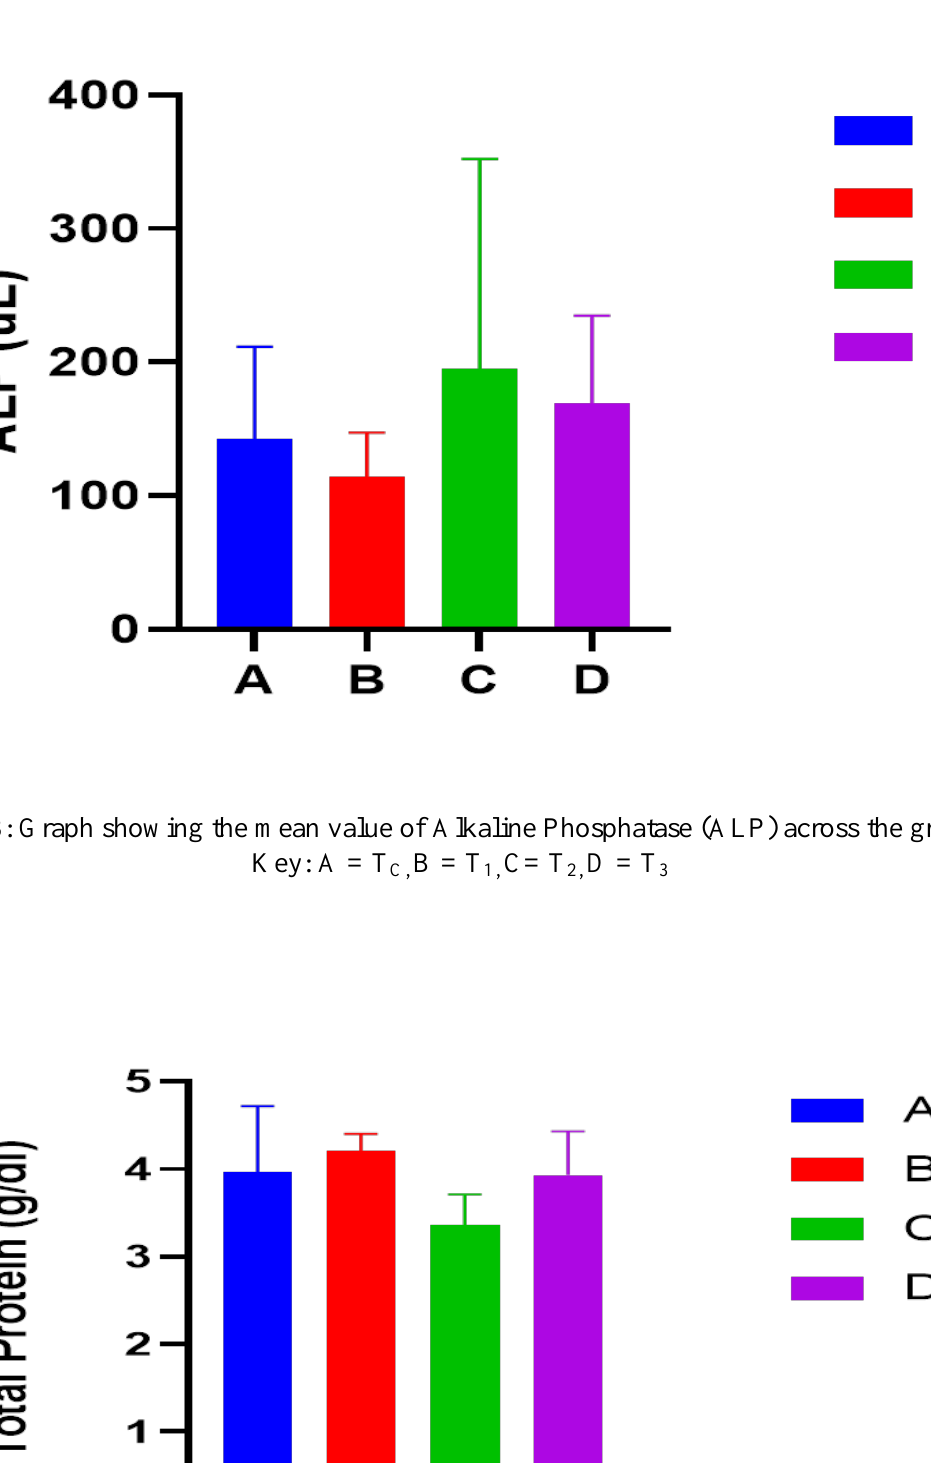
Fig. 4: Graph showing the mean value of Total Protein (TP) across the groups